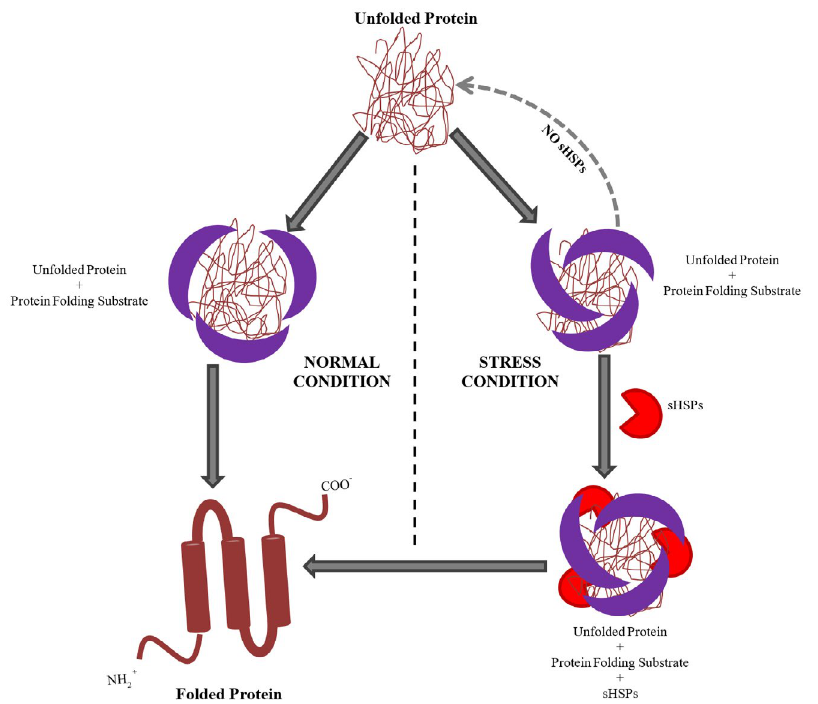
Fig 1. Model showing working of Small Heat Shock Proteins (sHSPs) system as chaperone. Protein folding is mediated by the cellular chaperon molecules(Protein folding substrate complex) which are active under the normal state of cell. sHSPs are expressed under the stress and they stabilize and assist the protein folding substrate complex to form proper confirmation and folding of the proteins. Loss of function of sHSPs in stress leads to formation of nonfunctional unfolded protein aggregates which can cause cell death, therefore sHSPs are rescuing cell under